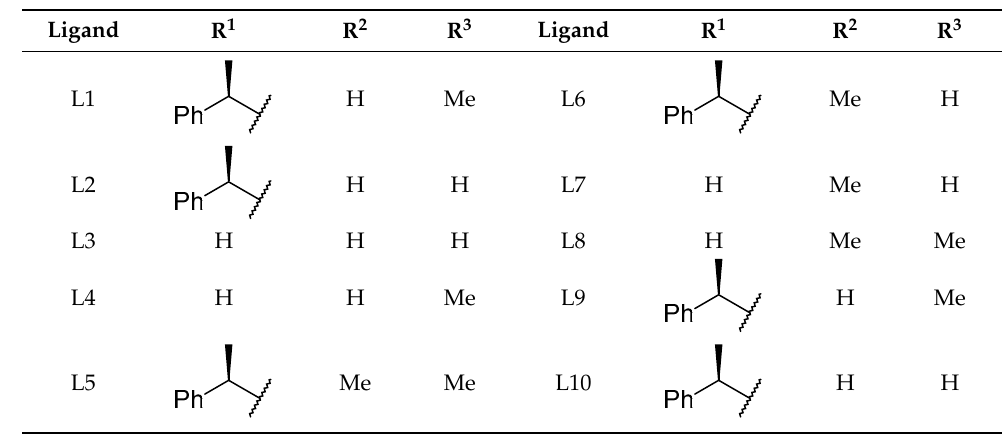
Figure 1. The structural elements necessary for the activity. Table 1. Ligands studied at pharmacophore study.